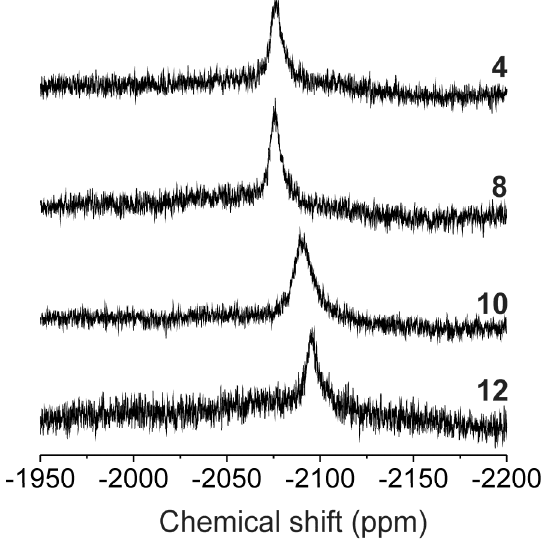
− δ ; ppm) of the complex ligand